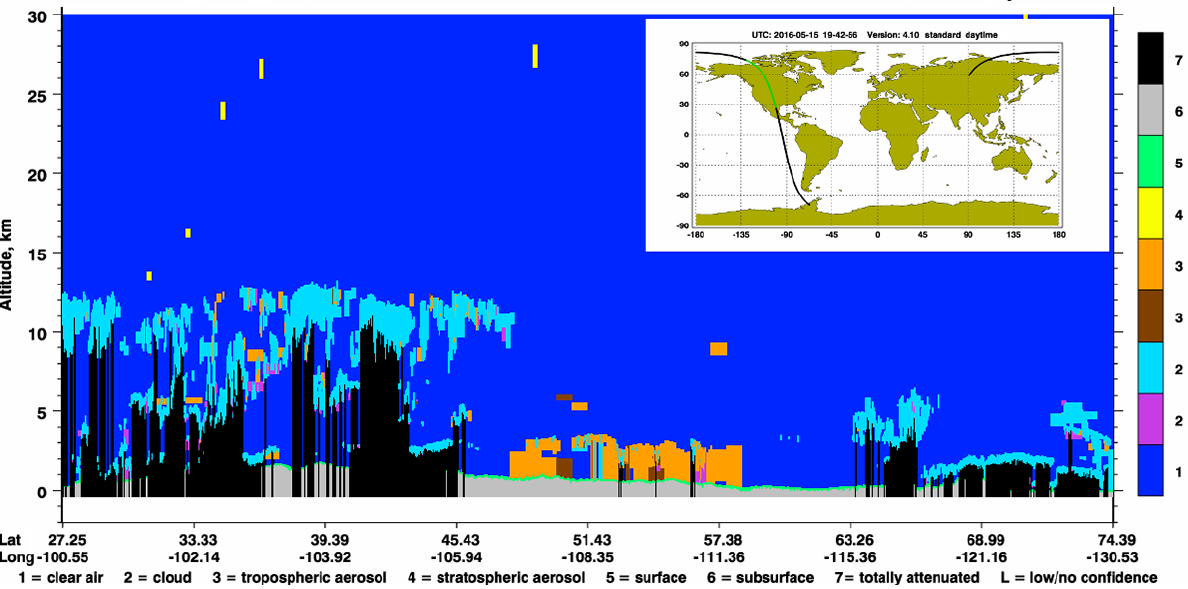
Figure B1. CALIPSO plots obtained from: https://www-calipso.larc.nasa.gov/data/BROWSE/production/V4-10/2016-05-15/2016-05-15_ 19-42-56_V4.10_3_6.png (last access: 19 February